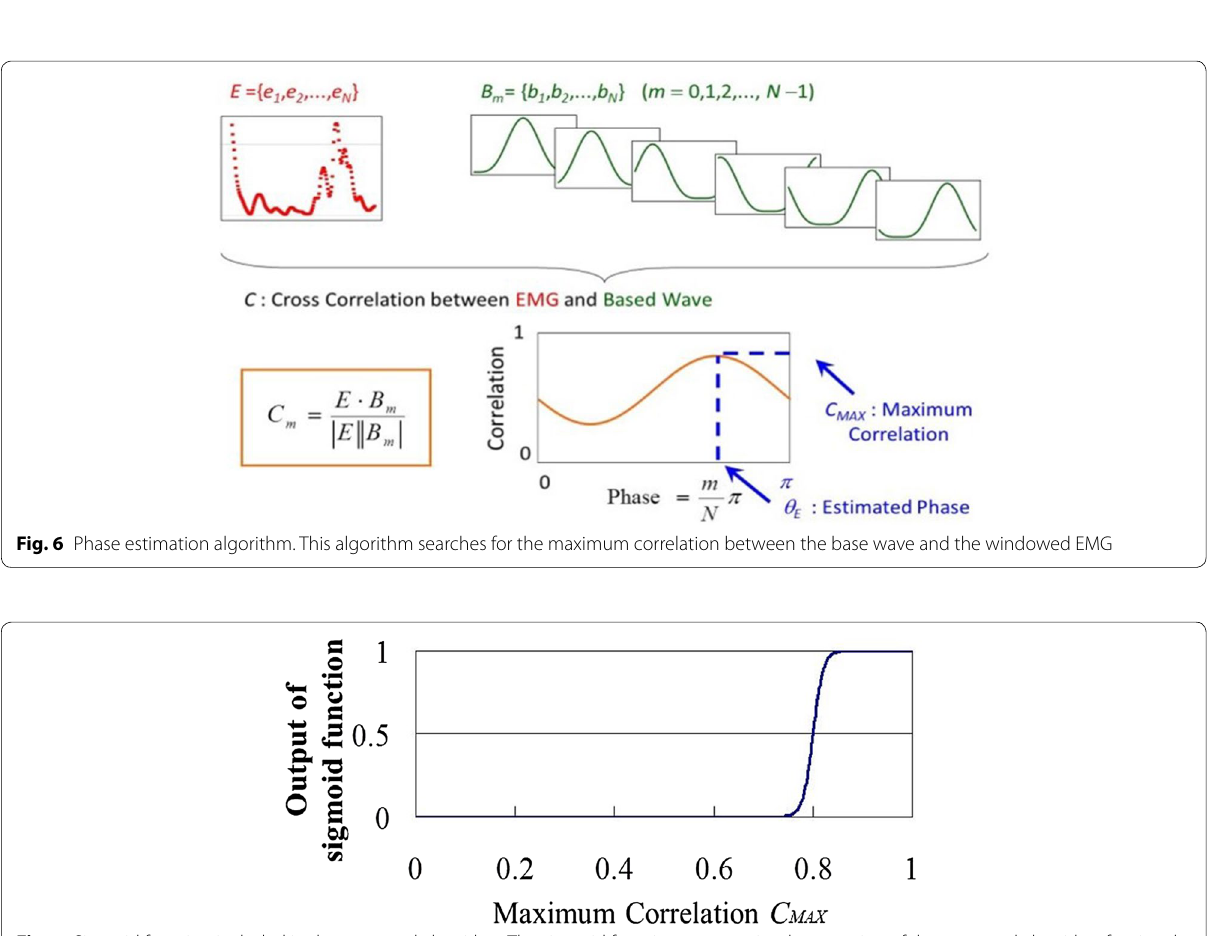
Fig. 7 Sigmoid function included in the proposed algorithm. The sigmoid function prevents implementation of the proposed algorithm for signals that have not been modulated by tremor